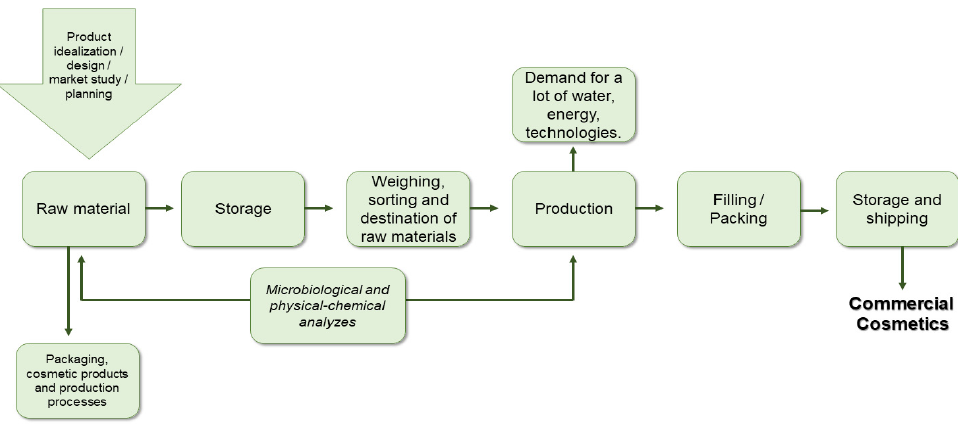
Figure 1. Stages involved in the cosmetics production process. Source: Authors, adapted from PEREIRA, F. S. G. (2010) [12].